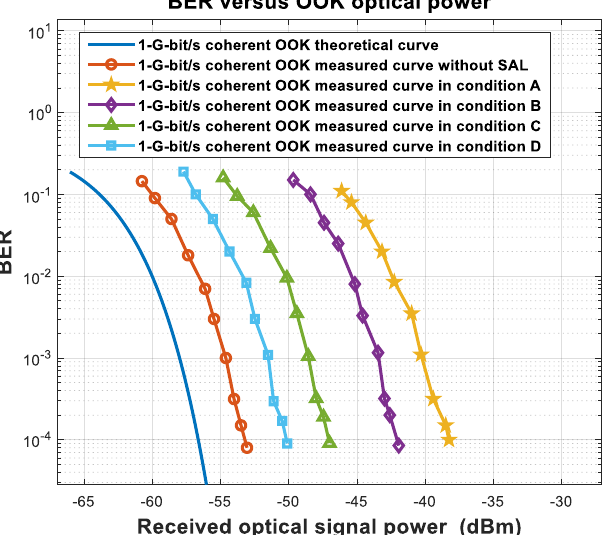
Figure 13. BER vs. coherent OOK optical power in different conditions.